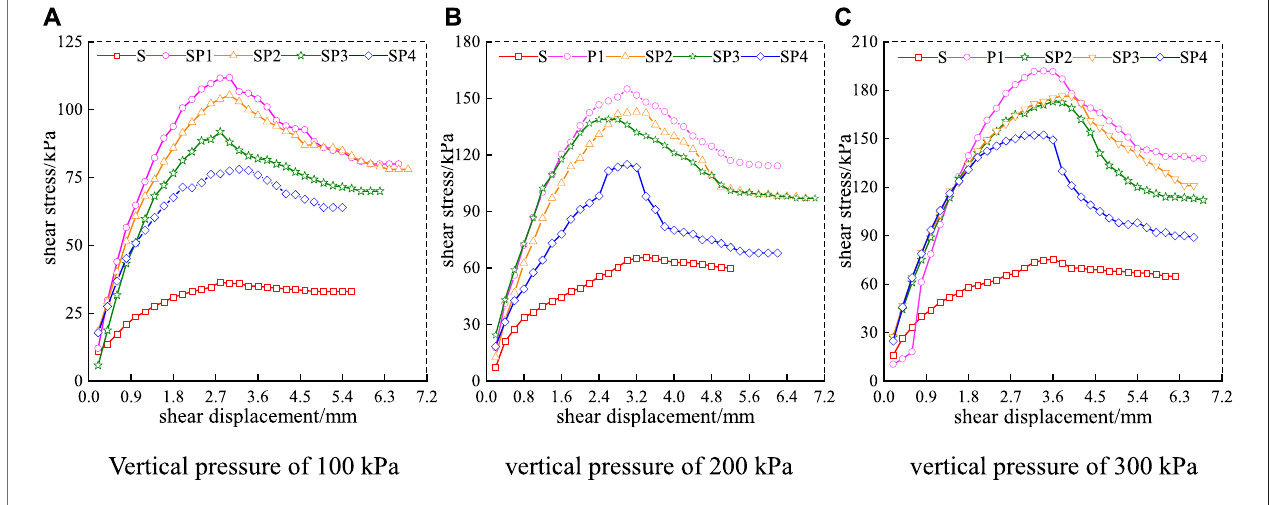
FIGURE 4 | Stress-strain curves of the different SP mixed silts under three vertical pressures. (A) Vertical pressure of 100 kPa (B) vertical pressure of 200 kPa (C) vertical pressure of 300 kPa